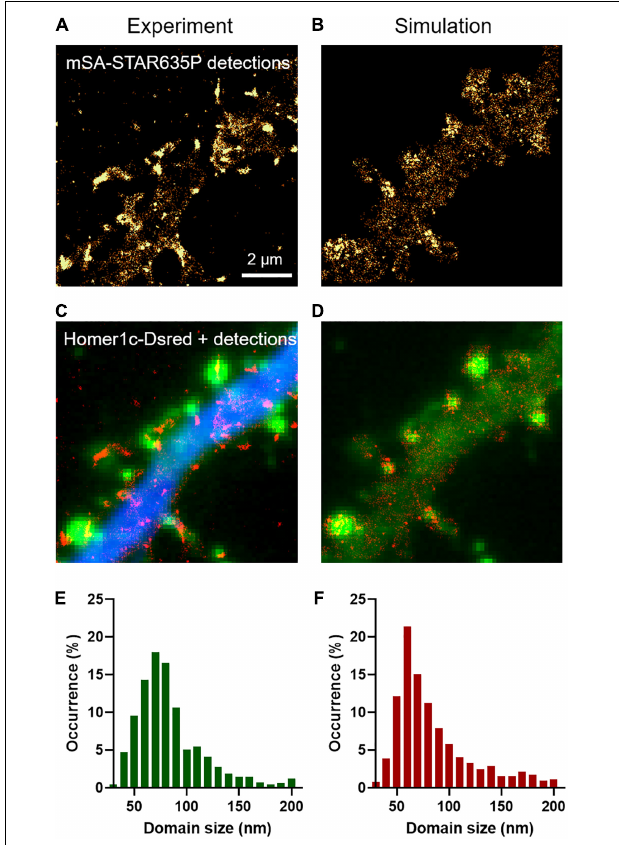
FIGURE 2 | Transient confinement domains of NLGN1. (A) Sum of all single mSA-STAR635P localizations detected over a live sequence of 2,000 frames of 20 ms in the dendritic segment of a neuron expressing BFP + shRNA to NLGN1, AP-NLGN1, BirA ER , and Homer1c-DsRed. The total number of localizations was 29,303. The gold color codes for the surface density of accumulated NLGN1 molecules over time. (B) Corresponding simulated image of NLGN1 localizations, generated by considering the diffusional trapping of NLGN1 at PSDs and the photophysics of mSA-STAR635P emission. The total number of localizations is 29,730. (C) Merged image showing the integrated number of experimental single molecule localizations per pixel (red), Homer1c-DsRed (green), and BFP (blue). (D) Merged image showing the integrated number of simulated single molecule localizations per pixel (red) and Homer1c-DsRed (green). (E,F) Distribution of the size (FWHM) of the NLGN1 confinement domains obtained by experiment and simulation, respectively. The experimental and simulated distributions of domain sizes were compared by a non-parametric Mann–Whitney test (non-significant difference, P -value =